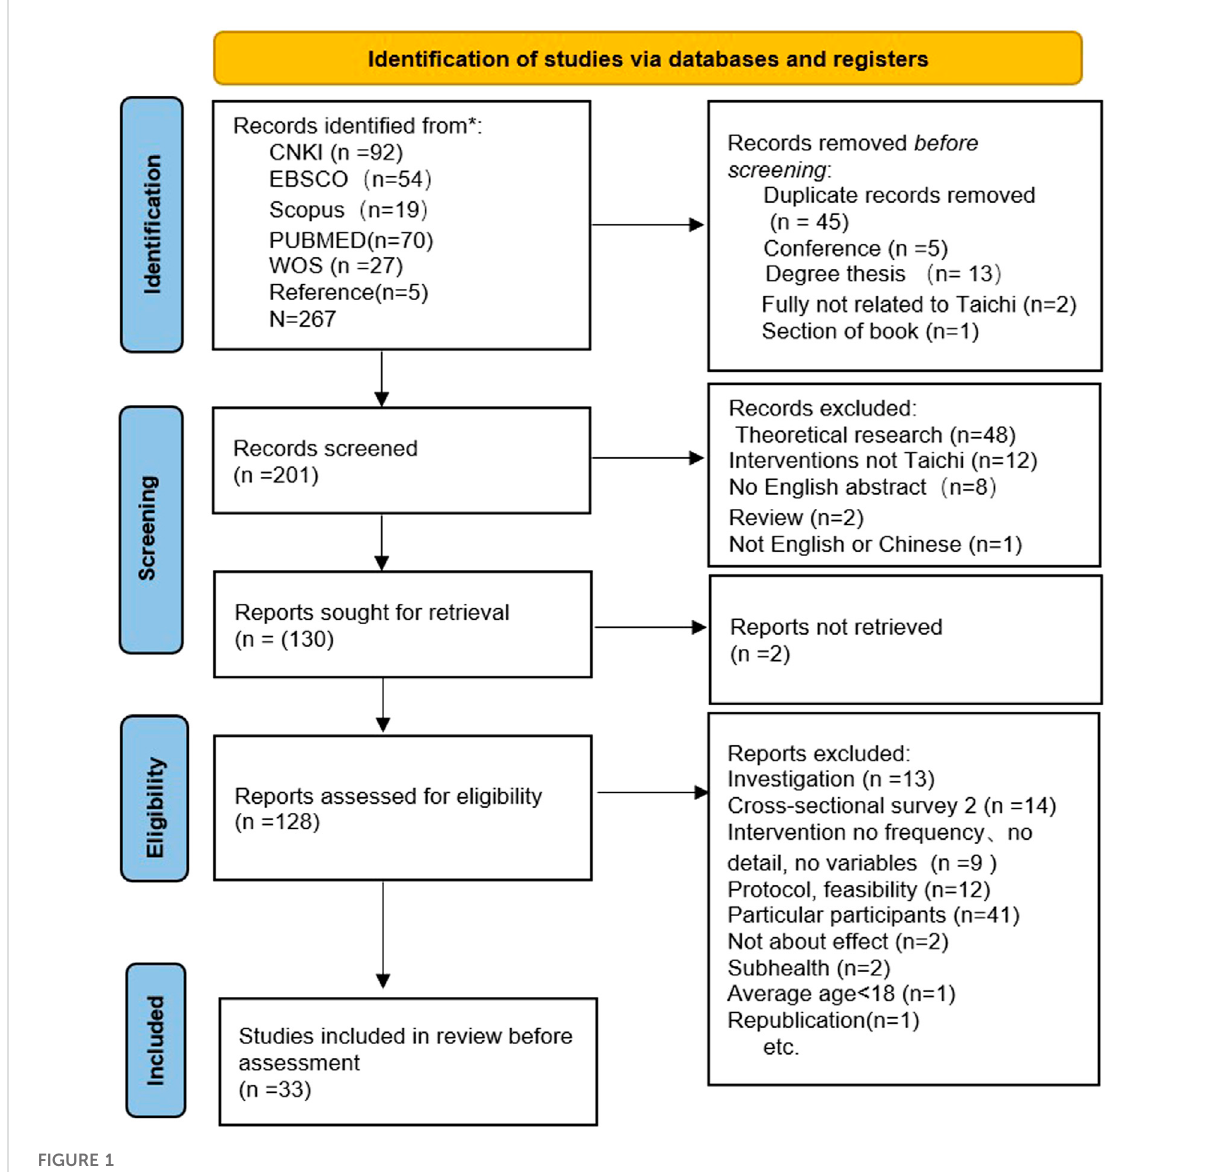
FIGURE 1 Article selection